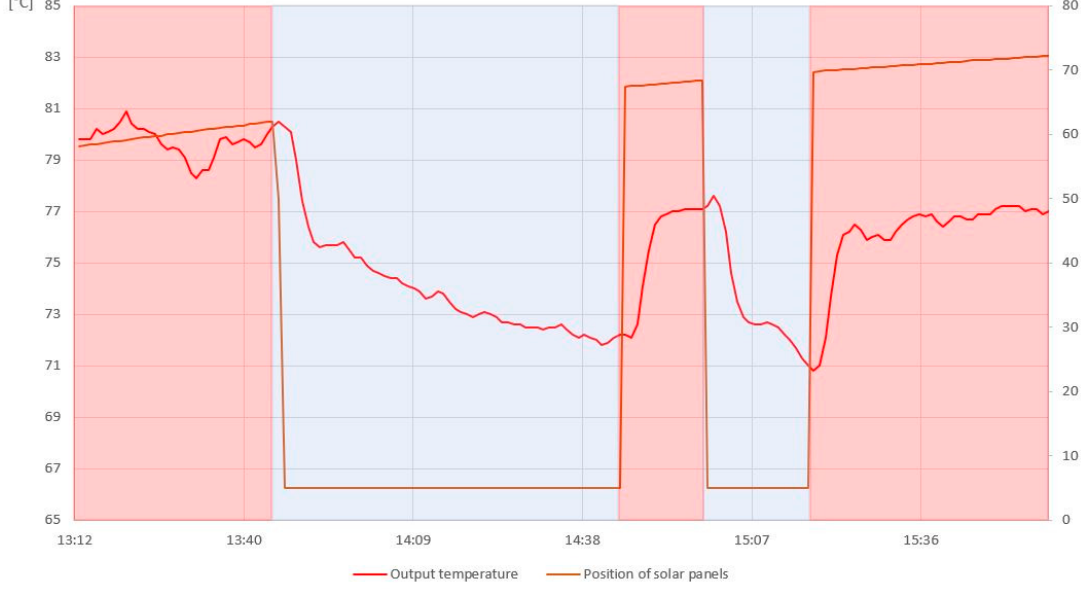
Figure 18. Outlet temperature curve depending on panel tilting.